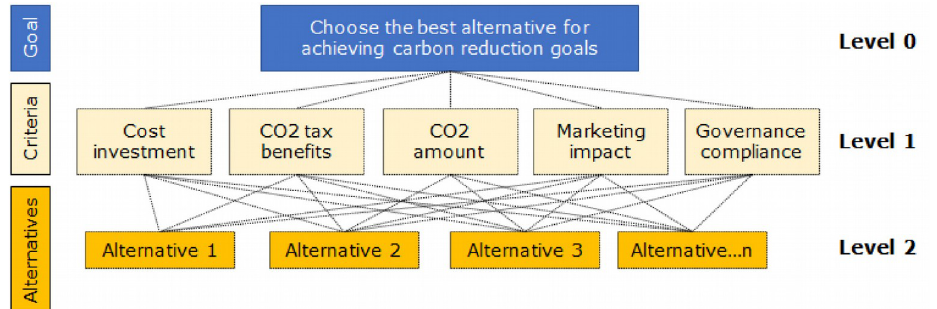
Figure 3. An example of AHP for the carbon alternatives selection (Based on AHP